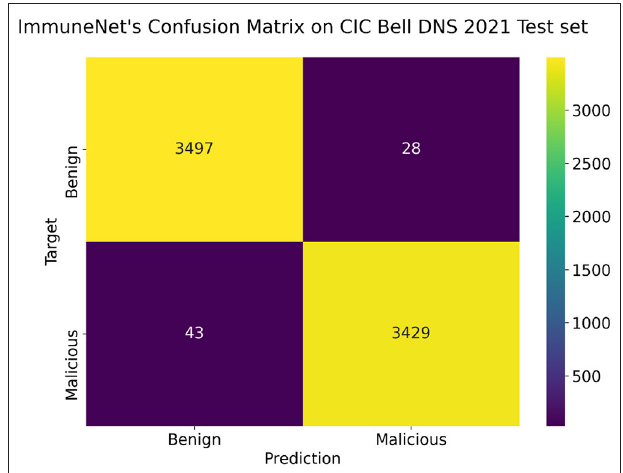
FIGURE 14 | Confusion MATRIX on the CIC Bell DNS 2021 test set for ImmuneNet.